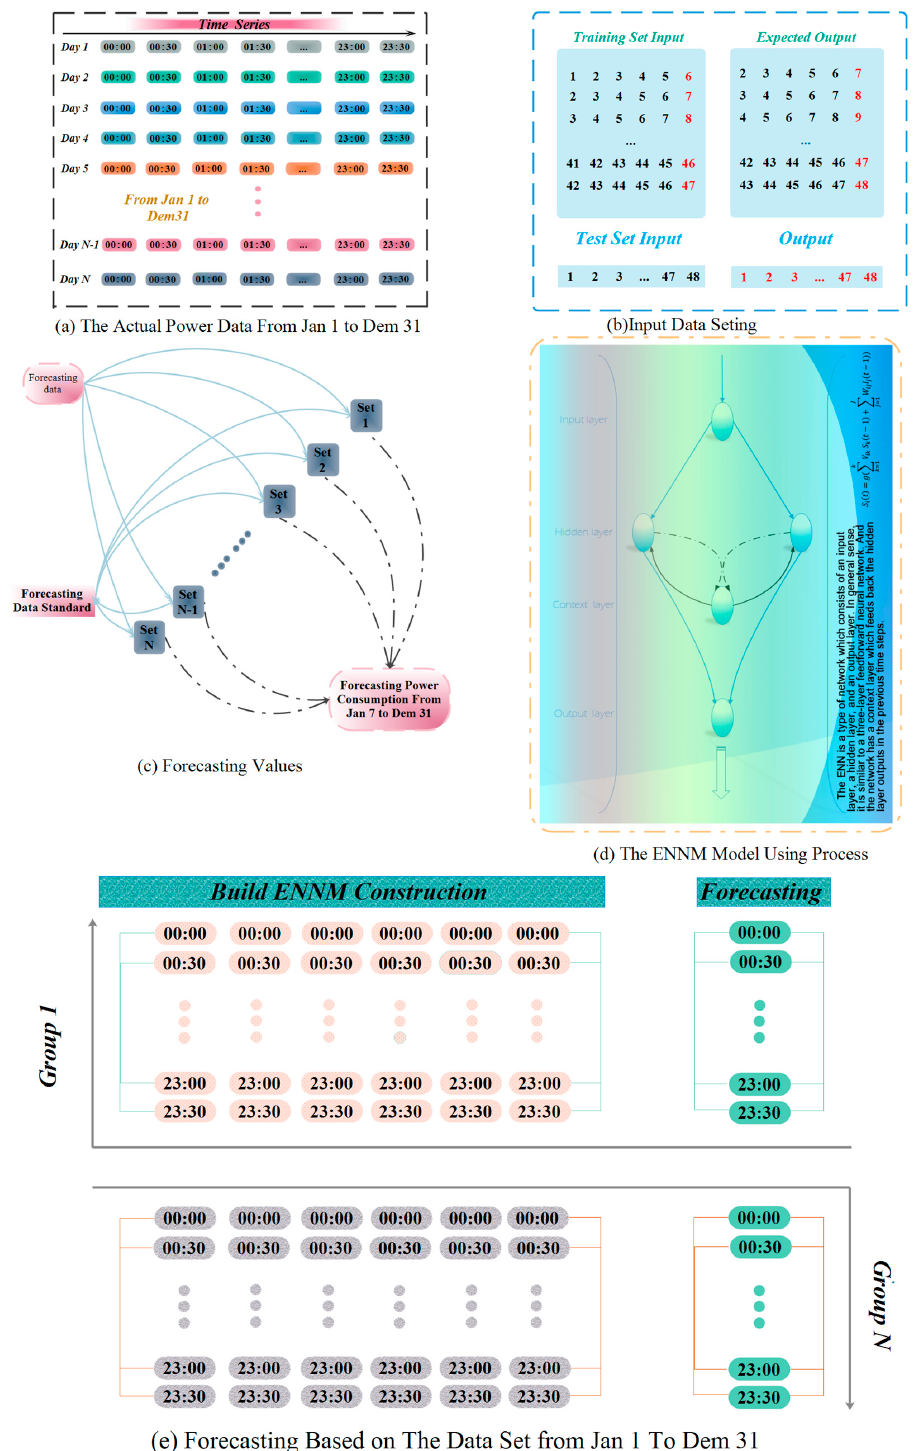
Figure 3. The data selection scheme.